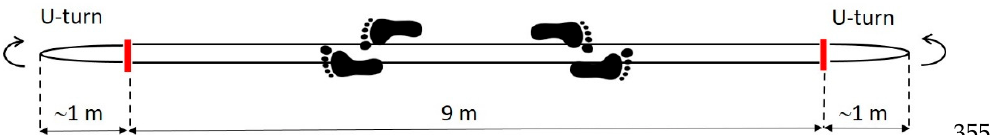
Figure 1. Schematic representation of the walking path. Subjects walked back and forth, without interruptions, along a straight path of 9 m, for approximately 5 min. U-turns were included in the analysis.